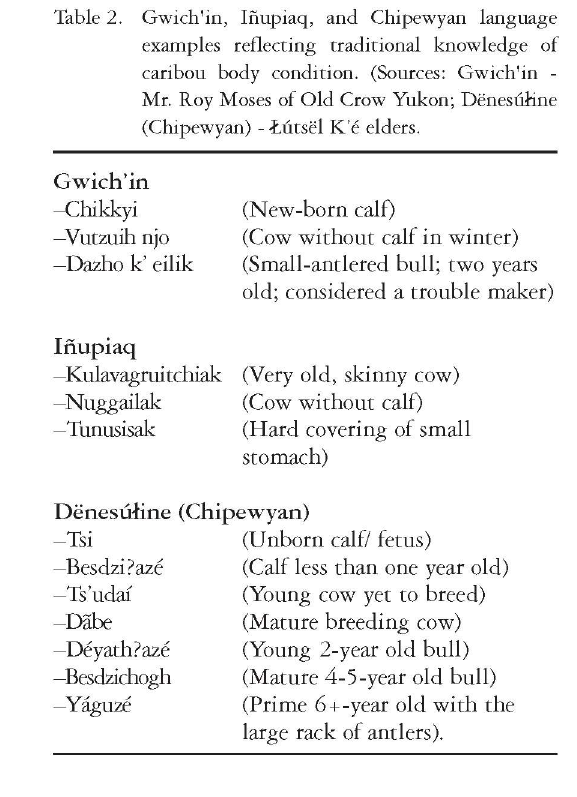
Table 2. Gwich'in, Inupiaq, and Chipewyan